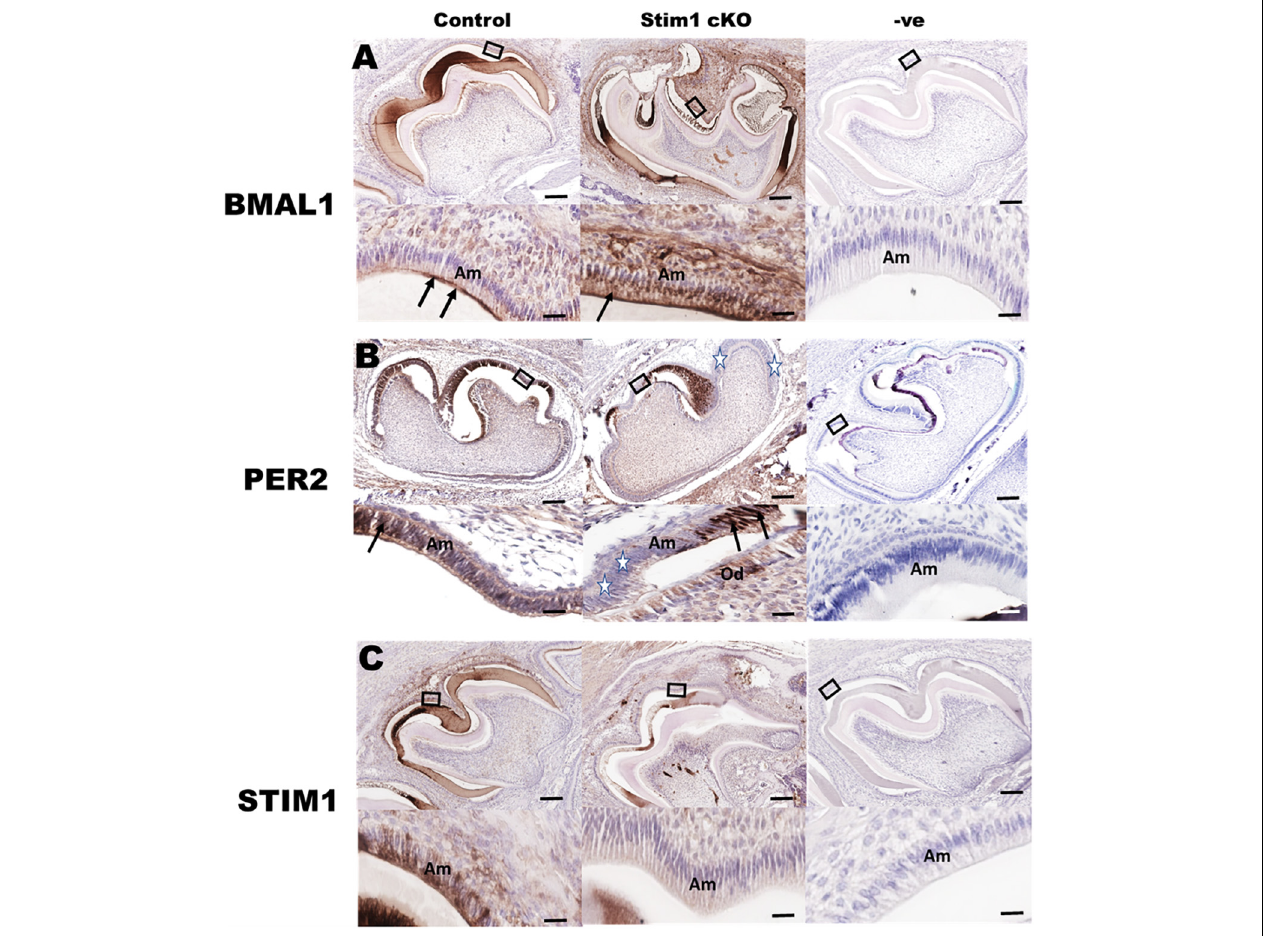
FIGURE 3 | Immunohistochemical validation of gene expression data. Representative images of mouse molar sections stained using specific antibodies against BMAL1 (A) , PER2 (B) , and STIM1 (C) . BMAL1 proteins levels are higher in the Stim1 cKO group compared to control and is mainly localized in the apical cytoplasm (arrows) of the ameloblasts. PER2 expression is weaker in the Stim1 cKO compared to control and is localized in the nucleus (arrows). Very weak STIM1 signal can be detected in Stim1 cKO ameloblasts which confirms the validity of our experimental model. The rectangular areas are enlarged in the lower panel of each image. White stars label the cells expressing very low levels of Per2 . Am, ameloblasts; Od, odontoblasts. Scale bars, 250 µ m in upper panels, 50 µ m in lower